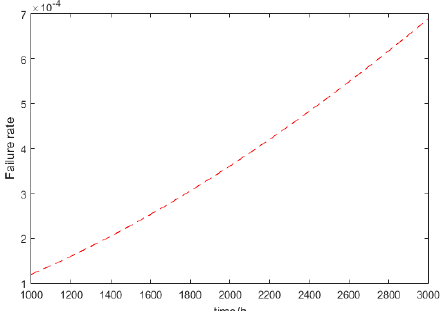
Figure 4. Failure rate upper confidence limit point estimation curve.